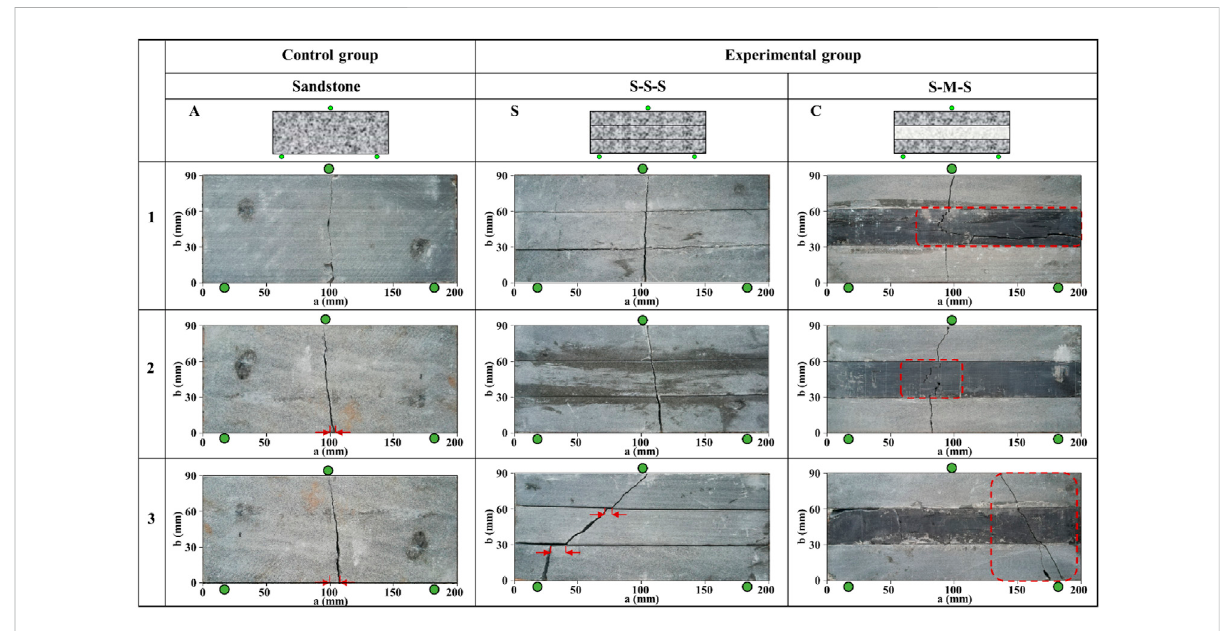
FIGURE 3 Crack propagation pattern of experimental specimens.